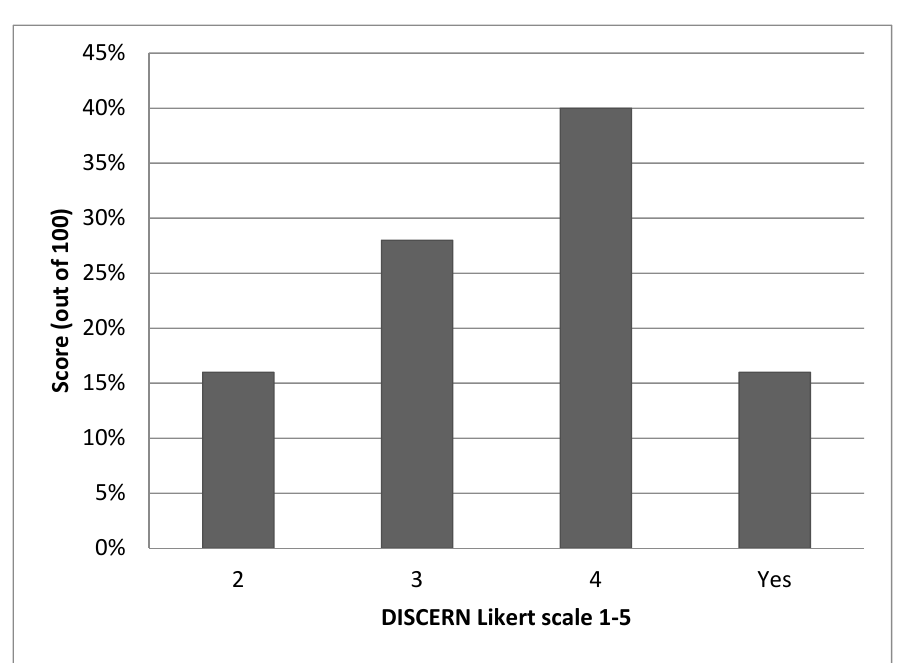
Figure 3. Assessment of additional sources of information by HPs.